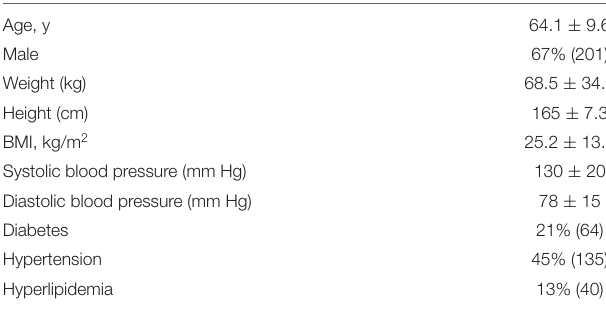
TABLE 1 | Baseline patient characteristics ( n = 300).